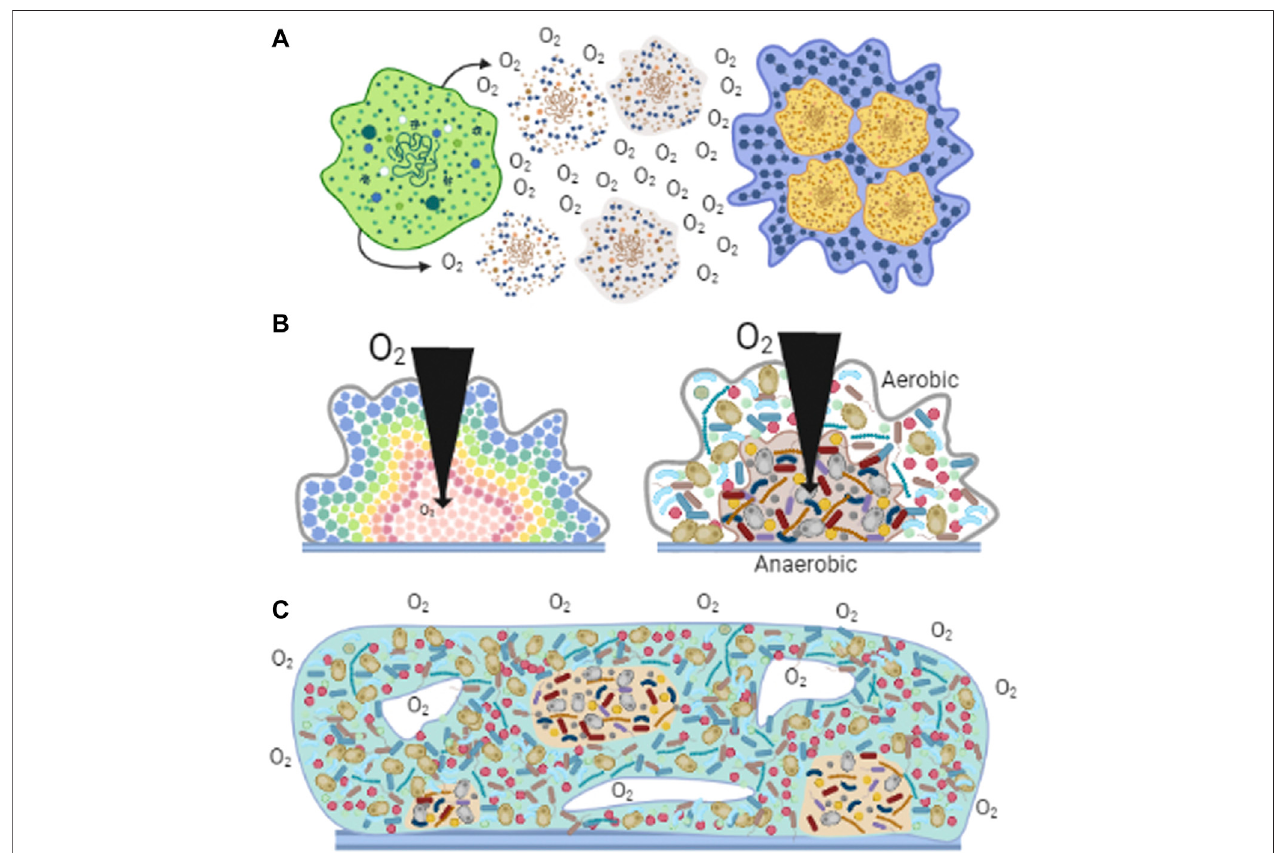
FIGURE 3 | Bio fi lms observed in nature. Cells associate to form bio fi lms forming different structures. (A) Cells react to high [O 2 ] by excreting polysaccharides that helpthemaggregate(Wingenderetal.,1999). (B) Diversityinbio fi lms.Inhomogeneousaggregates(leftpanel),atdifferentbio fi lmdepths,cellsperceivedifferentlevelsof O 2 , nutrients and other metabolites and thus adapt their metabolism (López et al., 2010). In heterogeneous aggregates (right panel), aerobic organisms are located on the surface, using O 2 before it enters deeper parts of the aggregate, enabling hypo/anaerobic organism to grow (Vilne et al., 2021). (C) Generation of microenvironments. Diverse cell species distribute according to their af fi nities for nutrients or [O 2 ] (Wessel et al., 2014). The formation of channels (white spaces) allows the dynamic distribution of molecules and providing a path for waste disposal (Frances et al., 2001).